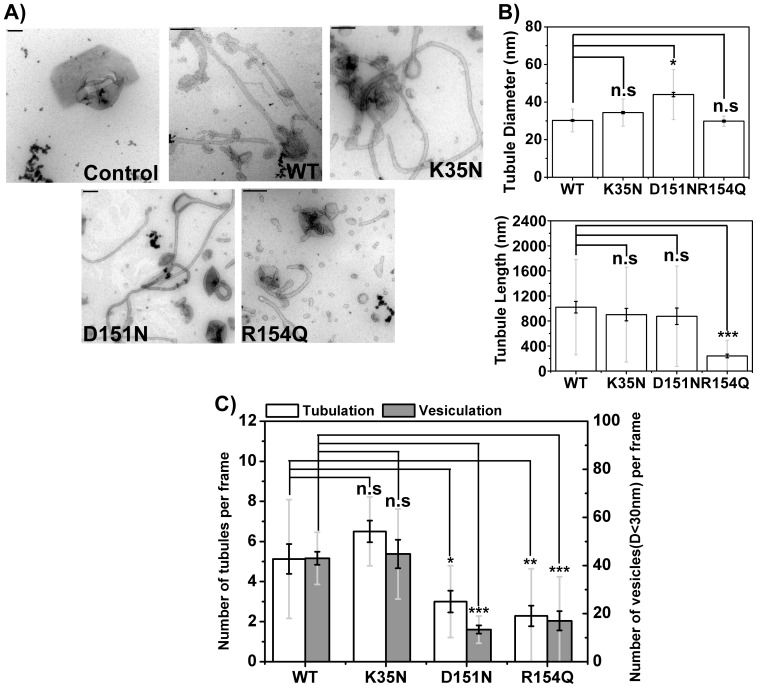
On membrane with high negative charge, only R154Q shows mild reduction in tubulation.A) Electron micrographs of liposomes (100% DOPS) tubulated by BIN1 N-BAR and mutants. Membrane tubules are observed for all BIN1 N-BAR variants. Scale bar: 200 nm. B) Quantifications of tubule diameter and length by BIN1 variants. R154Q mutation leads to increased tubule diameters and decreased tubule length comparing to WT BIN1 protein. C) Averaged occurrence of membrane tubules and vesiculated liposomes in each micrograph. K35N and D151N mutant are similar to WT N-BAR in membrane tubulation. All the disease mutants cause decrease in vesiculation to varied extent. Over 30 images were analyzed for quantifications. Error bars: standard error of the mean in black and standard deviation in light grey. Student t-test for statistical significance: n.s: p>0.05, *: p<0.05, **: p<0.01, ***: p<0.001.